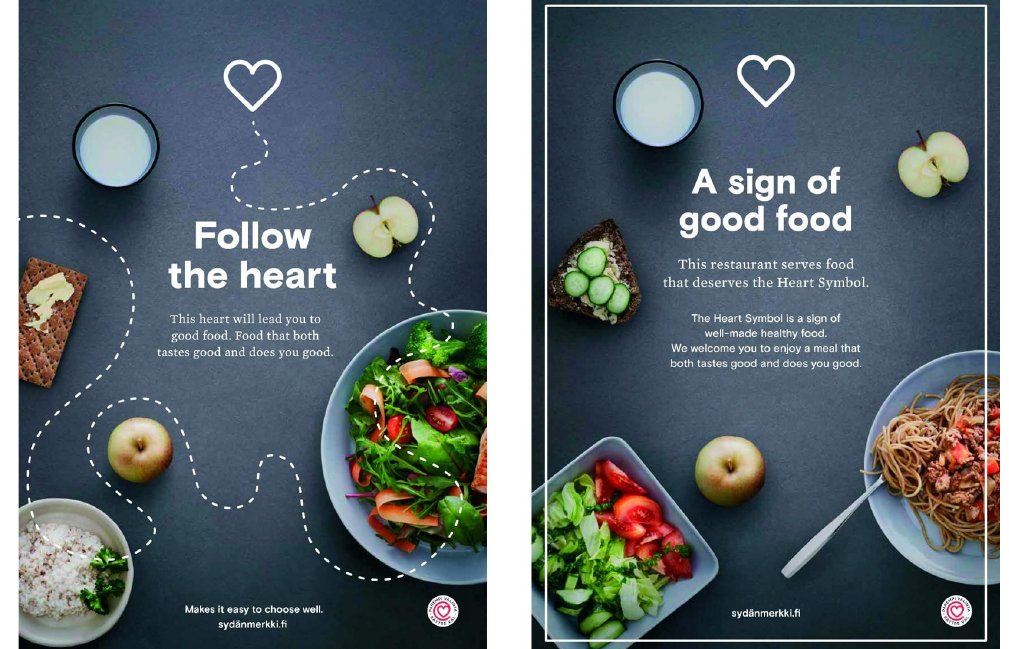
Figure 3. Posters that primed customers to notice and choose Heart-labelled foods. Original posters were in Finnish. Images reproduced with the permission of the Finnish Heart Association.